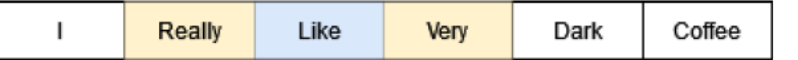
Figure 1. Illustration of the window for creating a context of the word “like” through W2V.